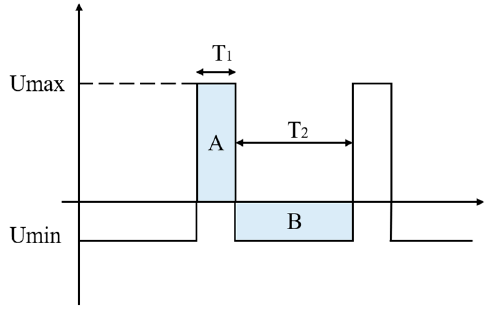
Figure 3. Ideal high-field asymmetric waveform ion mobility spectrometry voltage waveform.